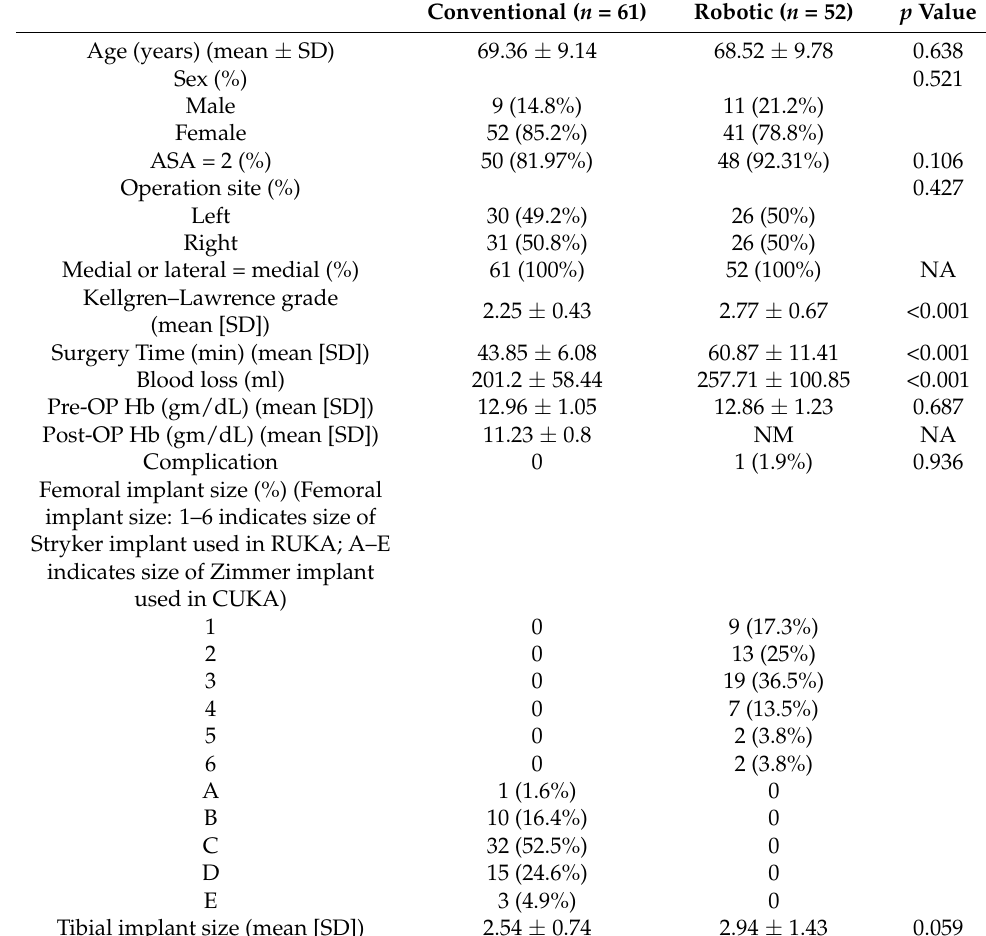
Table 2. Demographic characteristics and implant size in both